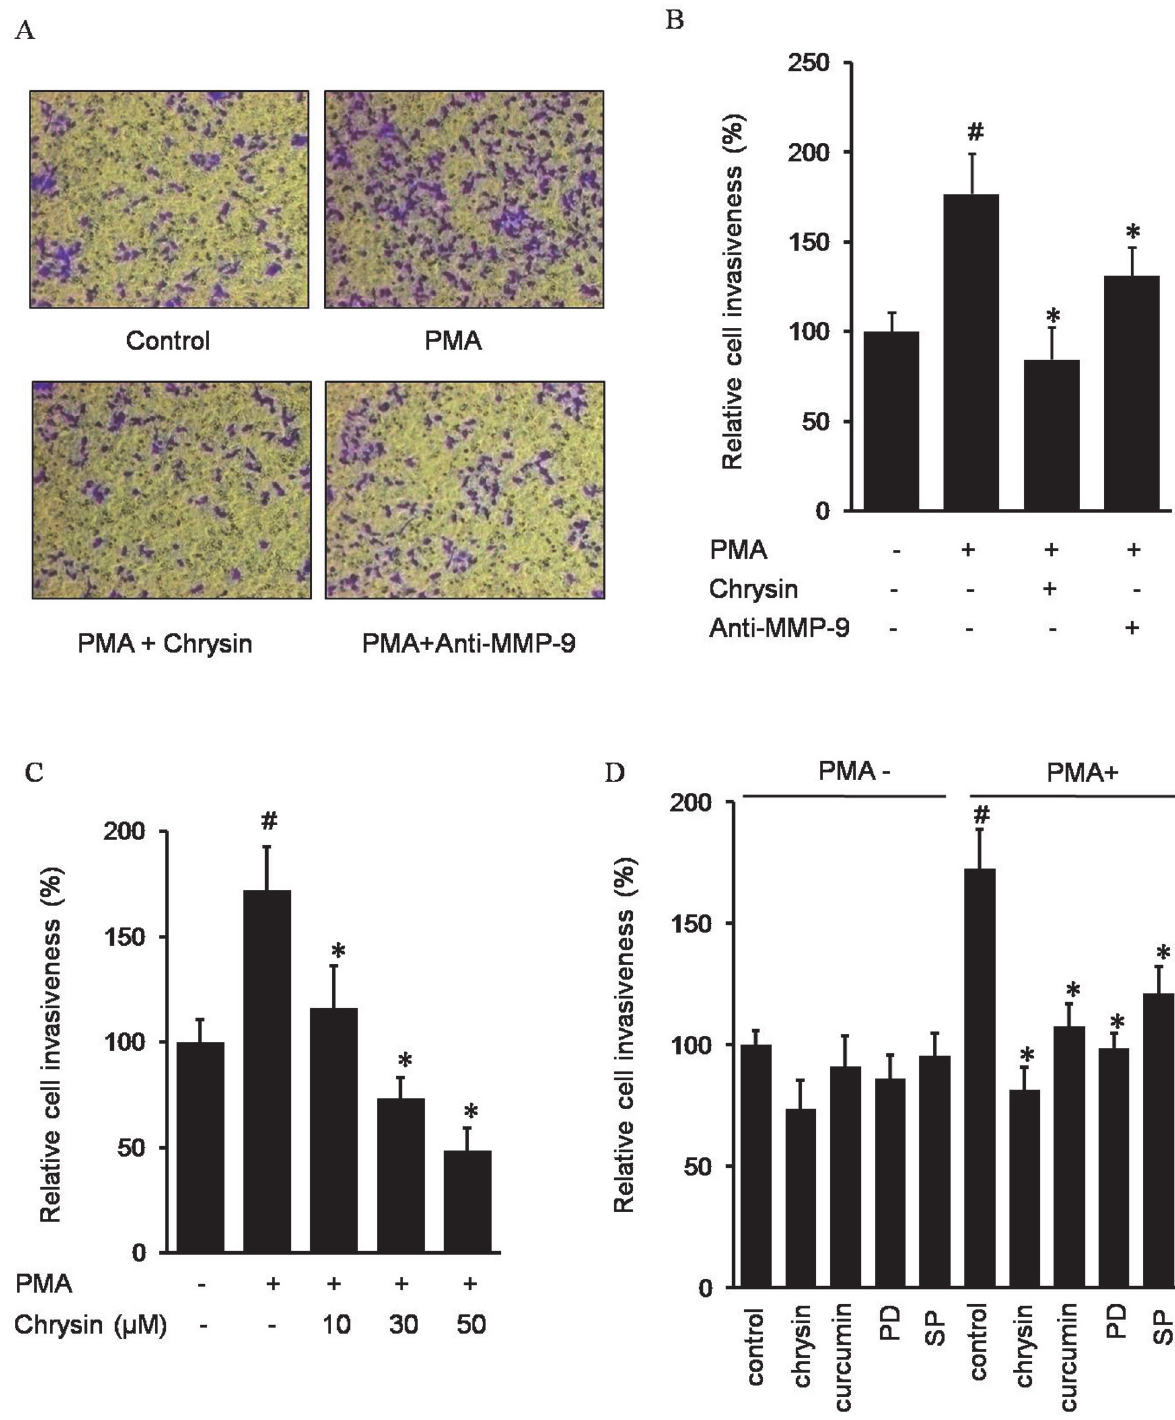
Fig 4. Chrysin inhibits AGS cells invasion by suppressing MMP-9. Cells were incubated with 50 nM PMA in the presence or absence of 30 μ M chrysin or 200 ng/ml MMP-9 antibody in BIOCOAT Matrigel apparatus for 24 h (A and B). Cells were incubated with 50 nM PMA in the presence of 0 – 50 μ M chrysin (C). Cells were incubated with 50 nM PMA in the presence of 30 μ M chrysin, 20 μ M curcumin, and either 30 μ M PD98059 (PD) or 30 μ M SP600125 (SP) (D). After incubation, the cells invaded the undersurface of the chambers and were counted using a phase contrast light microscope after staining with a Diff- Quick Stain Kit. The data represents the mean ± SD from triplicate measurements. # P < 0.05 versus control; * P < 0.05 versus only PMA.